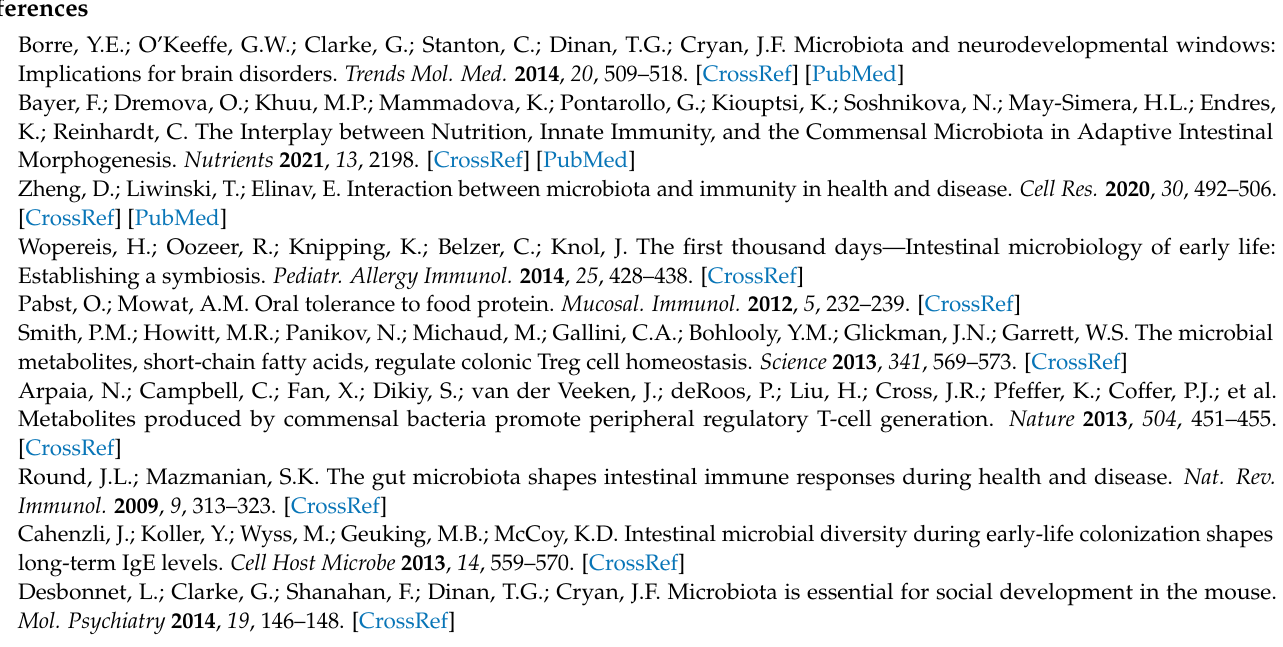
ulations of each diet group. Figure S4: Representative histograms of CXCR3 and T1ST2 of each diet. Figure S5: Th1 and Th2 response in MLN and spleen. Figure S6: Treg and Th17 response in MLN and spleen. Figure S7: Monoamine levels in the amygdala. Figure S8: Monoamine levels and turnovers in the PFC. Figure S9: Monoamine levels and serotonin turnover in dorsal hippocampus. Figure